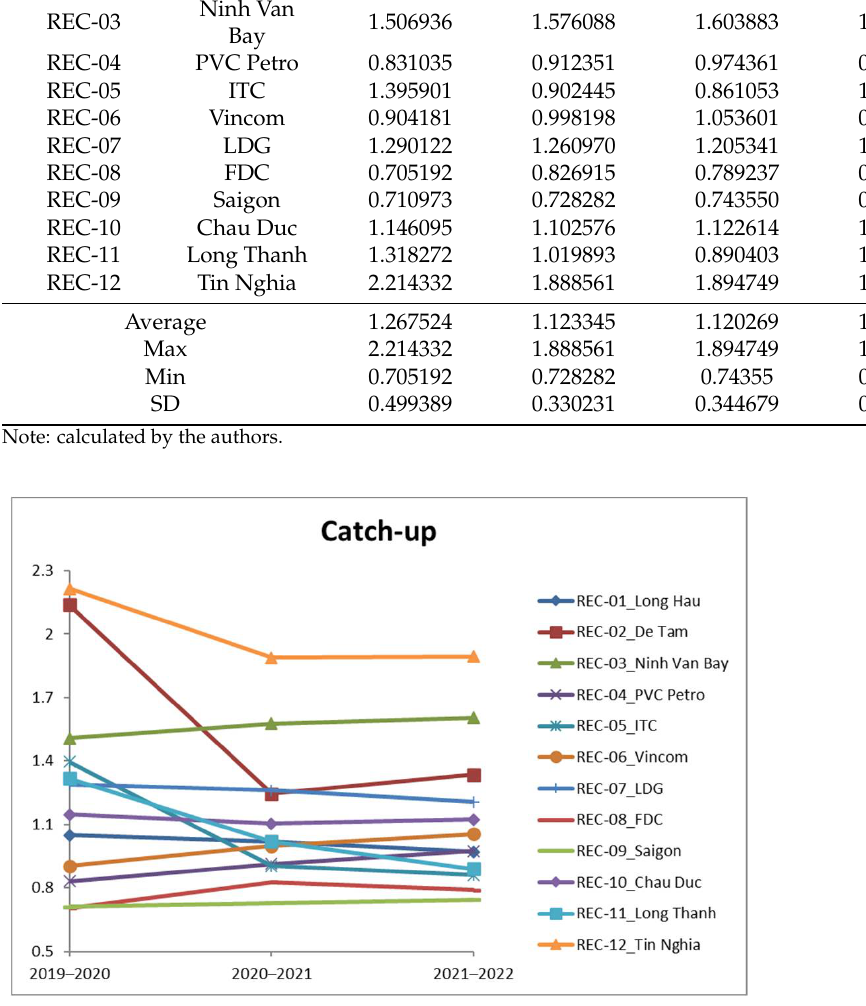
Figure 5. Technical efficiency change (2019–2022).